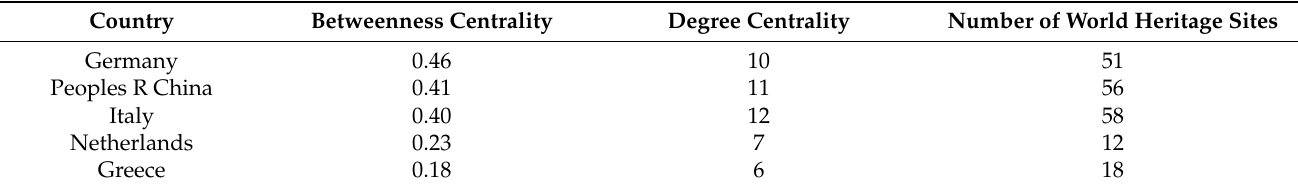
Table 4. The top five countries ranked by betweenness centrality. Country Betweenness Centrality Degree Centrality Number of World Heritage Sites